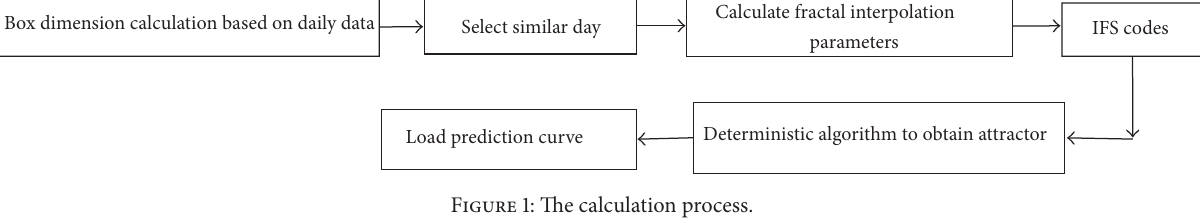
Figure 1: The calculation process.